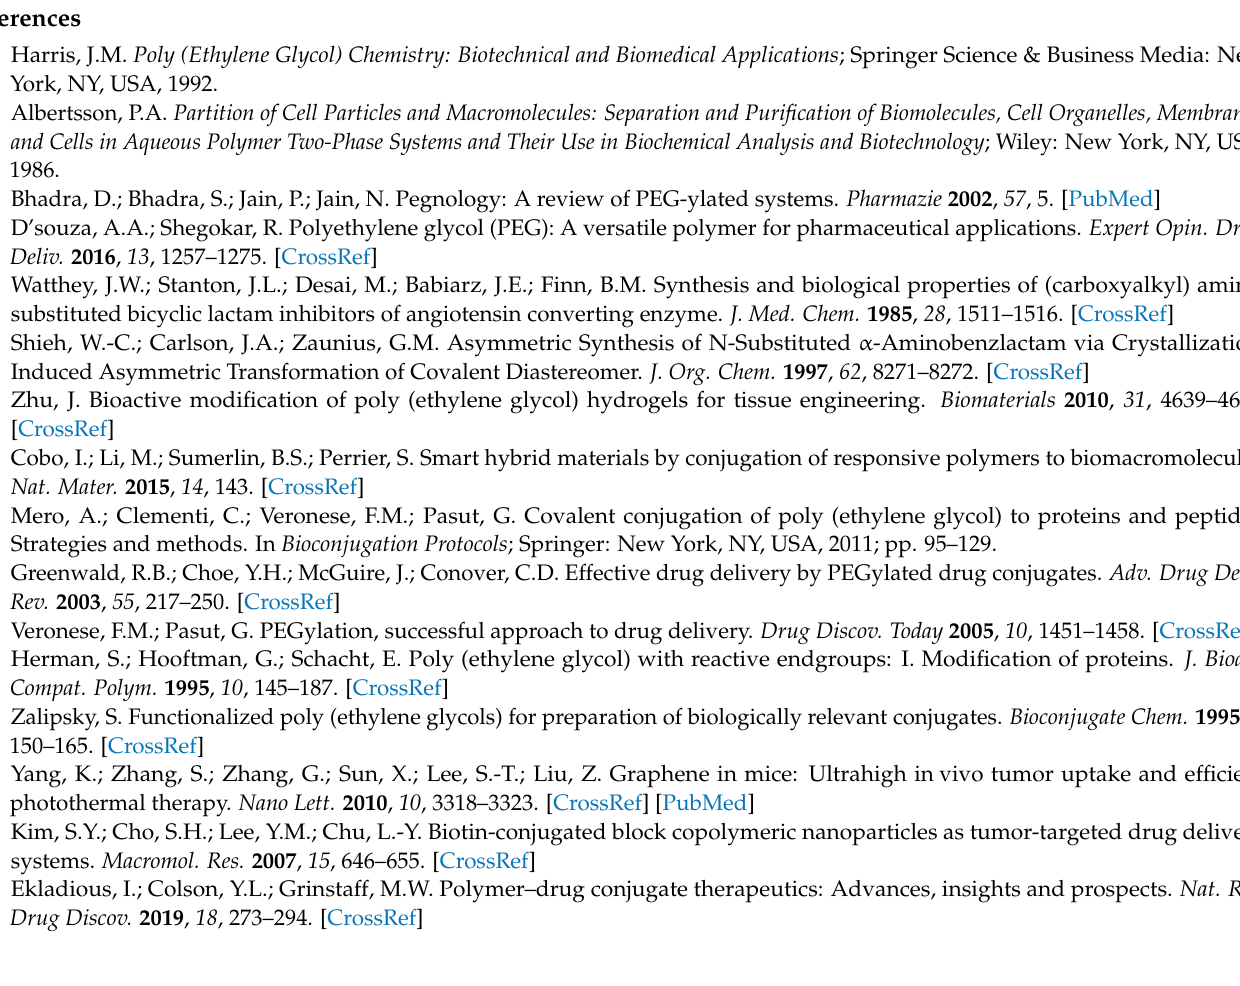
Table S1: Molecular weight characteristics of the polyglycols determined via 1 H NMR spectroscopy, MALDI-ToF MS and